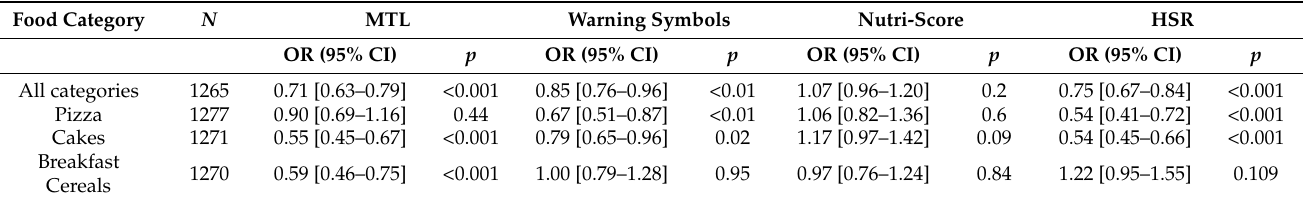
Table 3. Associations between front-of-pack label type and change in nutritional quality of food choices by food category ( n = 1278) using Guideline Daily Amounts (GDA) label as the reference for the